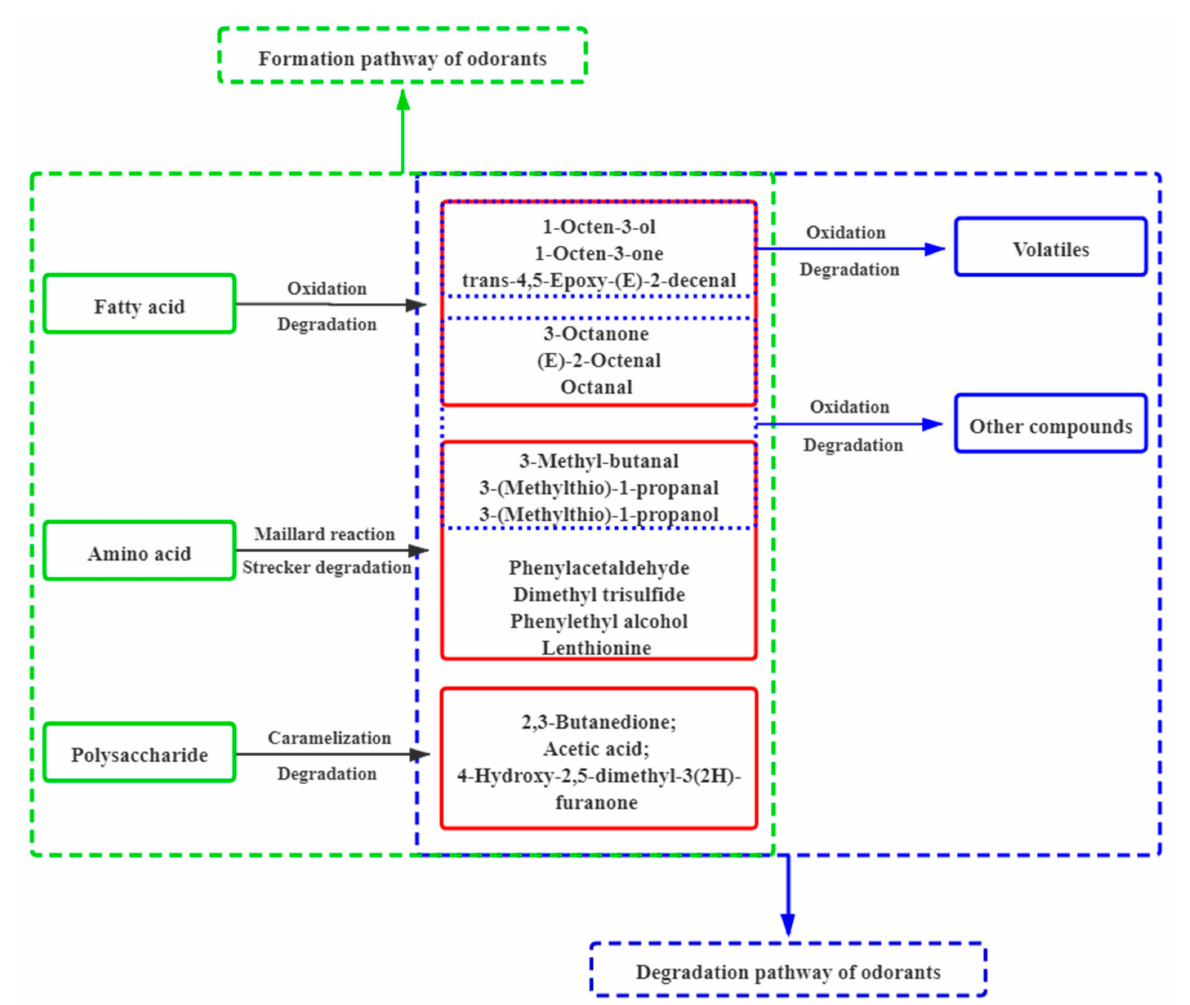
Figure 3. Aroma chemistry involved in the formation and degradation of key contributing odorants in shiitake